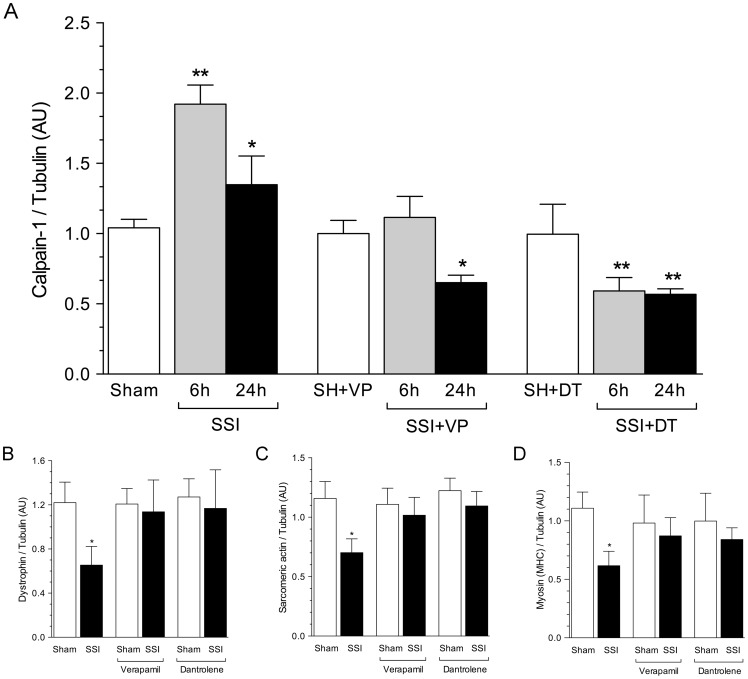
Verapamil (VP) and dantrolene (DT) abrogated calpain-1, dystrophin, sarcomeric actin, and myosin heavy chain changes induced by severe sepsis in mice.(The mean amount of calpain-1 in hearts from untreated mice (Sham) or in hearts of mice treated with either verapamil (SH+VP) or dantrolene (SH+DT) at 6 and 24 hours after sham operation were absolutely identical regarding each procedure and computed and represented as a single column). A. The mean amounts of calpain-1 in SSI hearts at 6 and 24 hours after CLP procedure were markedly increased in comparison with the mean amount in hearts of control mice after sham operation. In contrast, the mean amount of calpain-1 in SSI hearts from mice treated with verapamil at 6 hours after surgery was similar to the mean amount of calpain-1 in hearts from sham-operated treated with verapamil. The mean amount of calpain-1 in septic hearts from mice treated with verapamil at 24 hours after CLP procedure was significantly inferior to the mean amount of calpain-1 in hearts from sham controls. The mean amounts of calpain-1 in SSI hearts from mice treated with dantrolene at 6 and 24 hours after operation were significantly lower in comparison with the mean amount of calpain-1 in sham controls treated with dantrolene. B. The mean amount of dystrophin in SSI hearts was significantly reduced in comparison with the mean value in sham controls. The mean amounts of dystrophin in SSI hearts from mice treated with either verapamil or dantrolene were similar to those observed in sham-operated mice treated with either verapamil or dantrolene and sham-operated untreated mice. C and D. The mean amounts of actin and myosin in SSI hearts were markedly reduced compared to sham control values. Contrasted with these results, the values of sarcomeric actin and myosin in SSI hearts from mice treated with either verapamil or dantrolene were similar to those disclosed in hearts from sham-operated mice treated with verapamil or dantrolene and sham-operated untreated mice. (*, P<0.01; **, P<0.001).